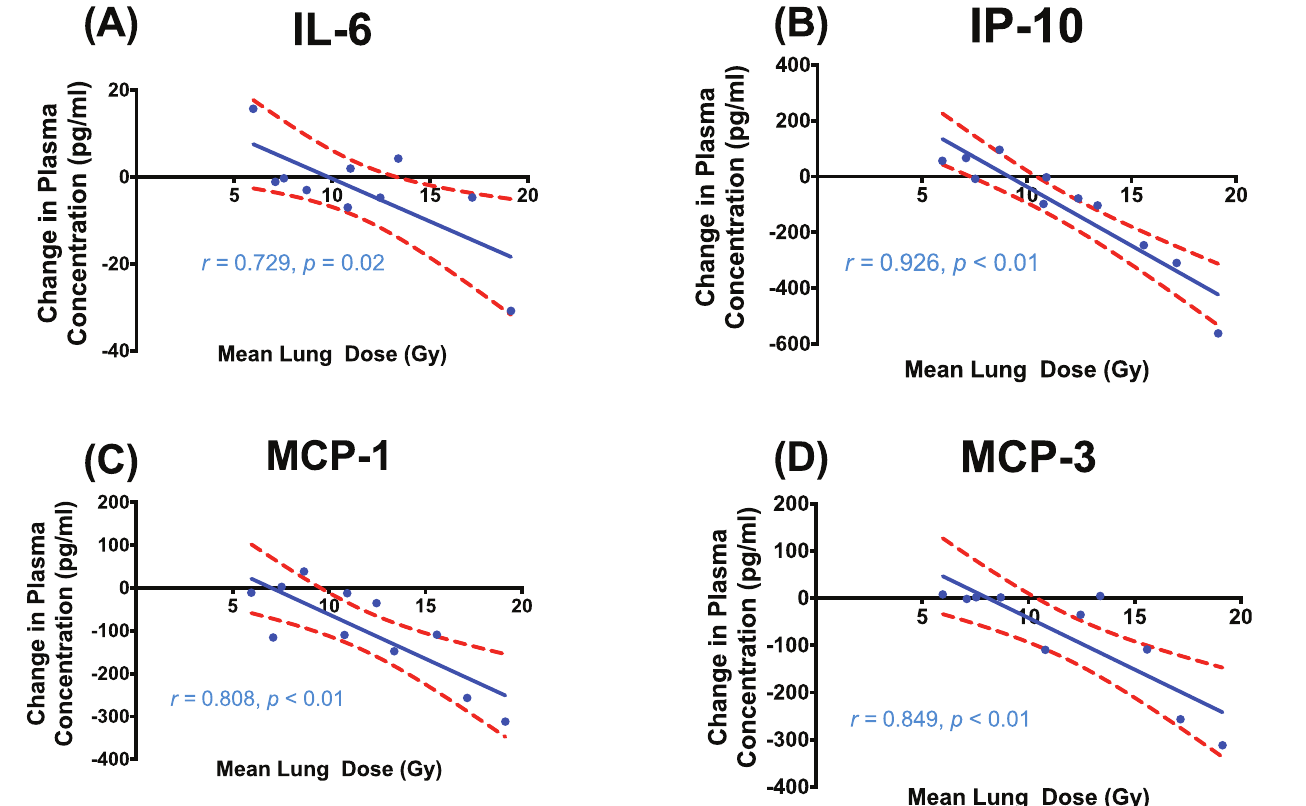
Figure 4. Correlation between mean lung dose (MLD) and the change in plasma cytokine concentration from baseline to 1-hour post irradiation for IL-6 (A), IP-10 (B), MCP-1 (C) and MCP-3 (D). Linear-regression line (blue) is displayed with 95% confidence intervals (red broken line).